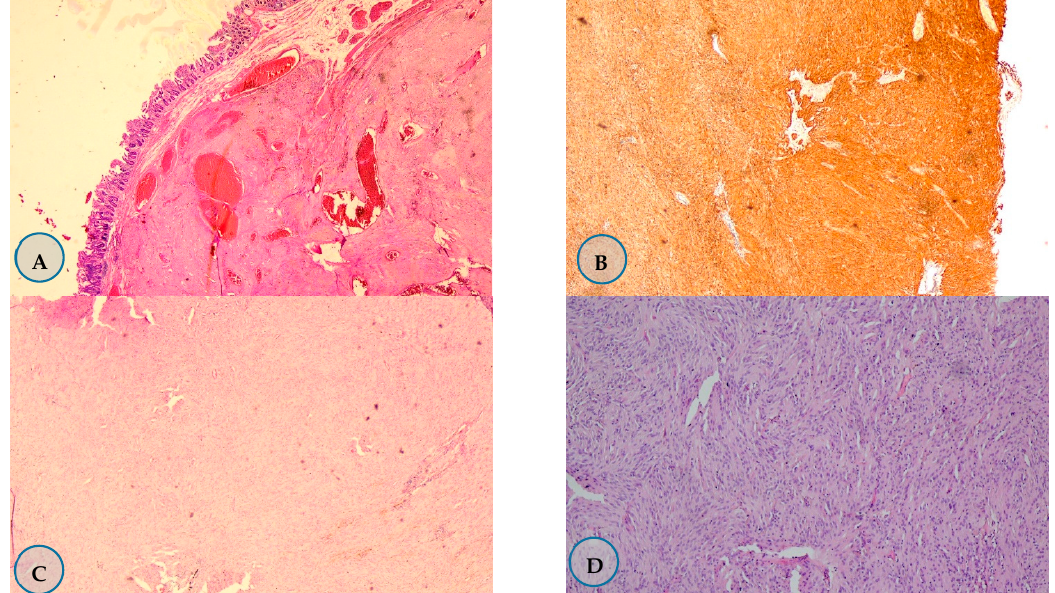
Figure 2. Staining samples of Gastrointestinal stromal tumors (GIST) at different stages. ( A ) Stage I jejunum localized the GIST. Hematoxylin-eosin staining of × 20. ( B ) Stage 2 Stomach-localized GIST. C Kit 100% positive staining by immunohistochemistry × 40. ( C ) Stage 3 small intestine localized GIST. Hematoxylin-eosin staining of × 40. ( D ) Stage 4 GIST with mesenteric localization. Hematoxylin-eosin staining ( ×